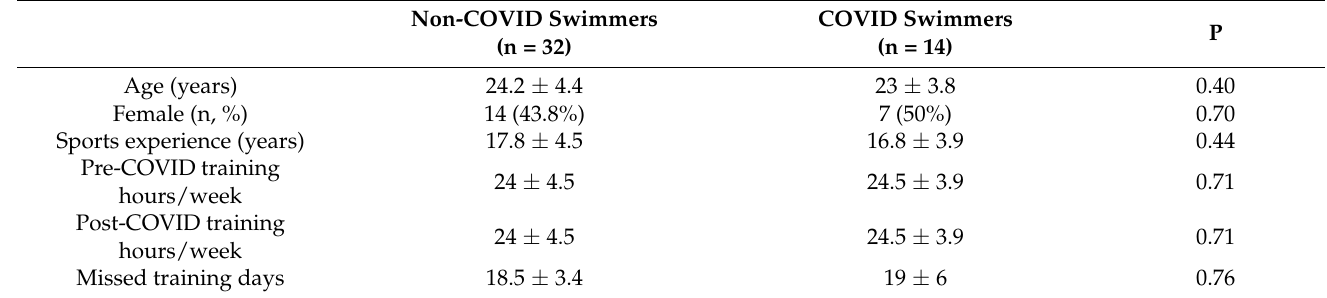
Table 1. Baseline characteristics according to COVID-19